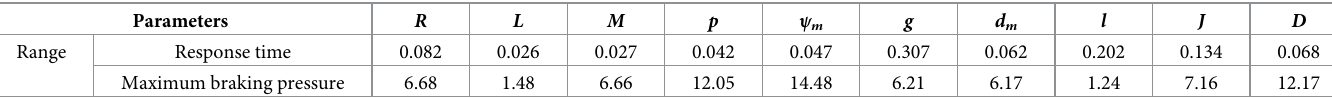
Table 6. Results of the range analyses.